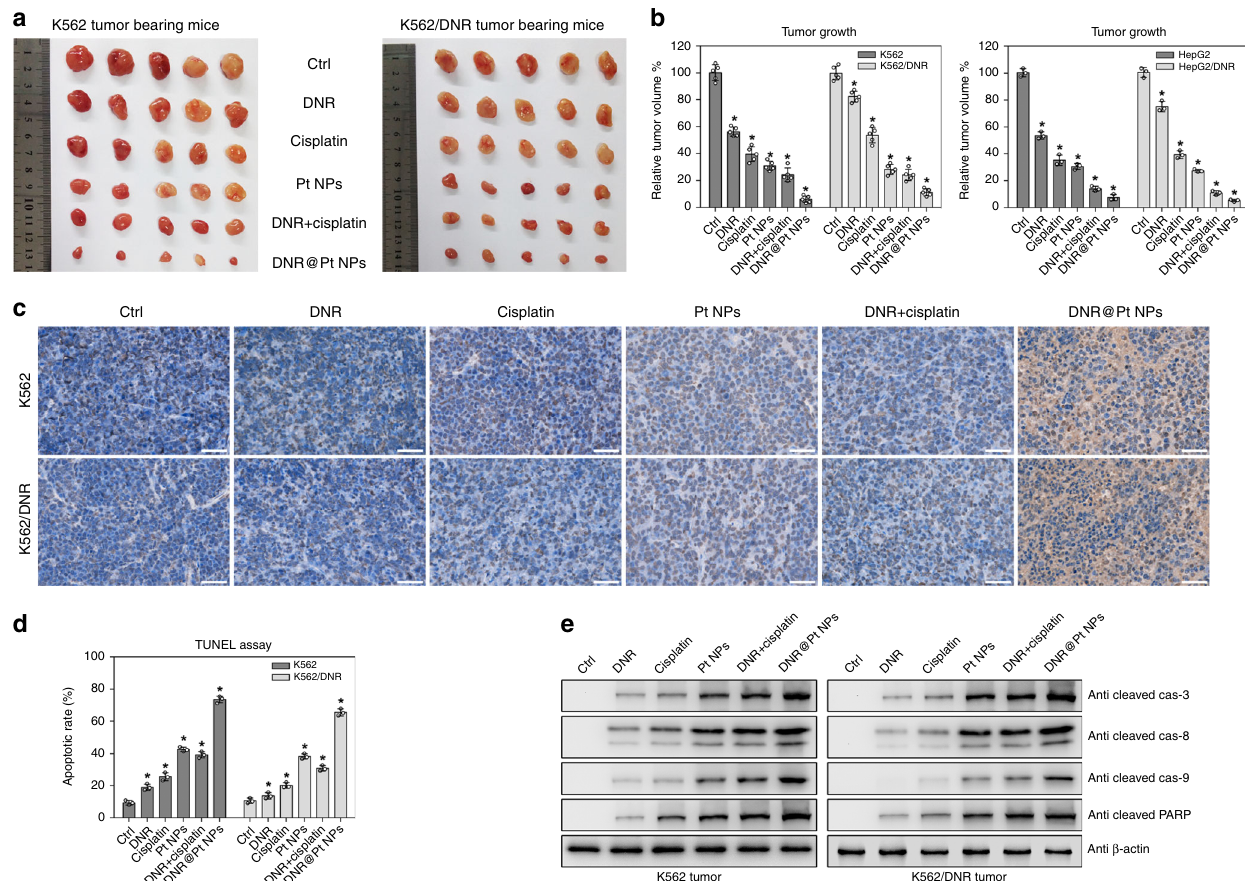
Fig. 6 Pt NPs reverse the DNR resistance of tumor cells. a DNR-sensitive and DNR-resistant K562 cell tumor-bearing nude mice were treated with PBS (ctrl), 0.1 mg kg − 1 DNR (DNR), 1 mg kg − 1 cisplatin (cisplatin), 1 mg kg − 1 Pt NPs (Pt NPs), 0.1 mg kg − 1 DNR combined with 1 mg kg − 1 cisplatin (DNR + cisplatin) or 1 mg kg − 1 DNR-Pt NPs (DNR@Pt NPs). The tumors were excised and their volumes measured. b DNR-sensitive and DNR-resistant K562